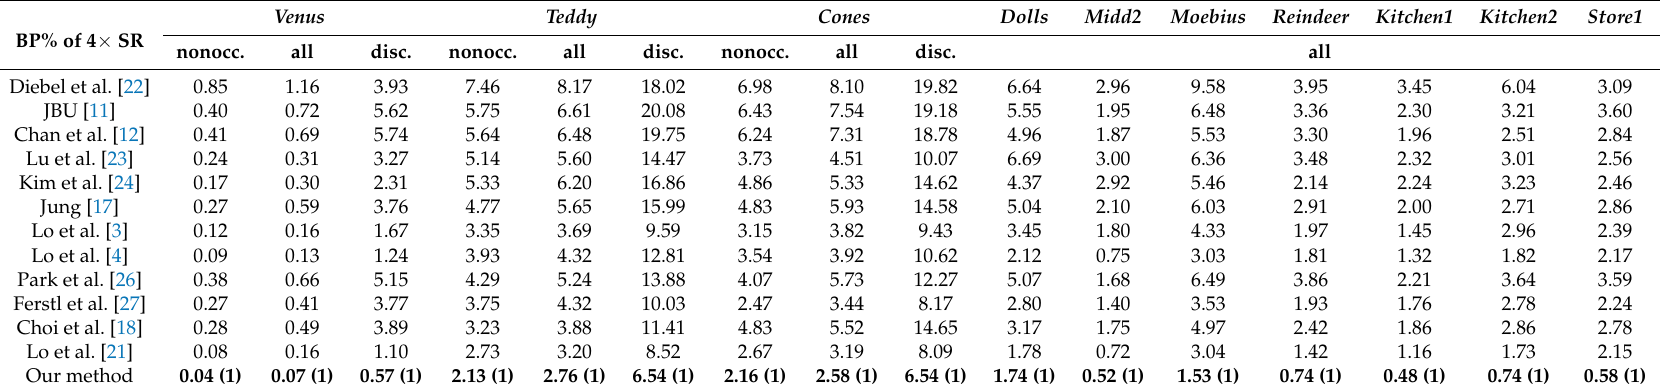
Table 1. Comparisons of Bad Pixel percentages (BP%) with upsampling factors of 4. For each image, the ranking of our approach is shown in parenthesis, and the best performance is shown in bold. nonocc., non-occluded; disc., discontinuity. Venus Teddy Cones Dolls Moebius Reindeer Kitchen1 Store1 BP% of 4 × SR nonocc. nonocc. all Diebel et al. [22]